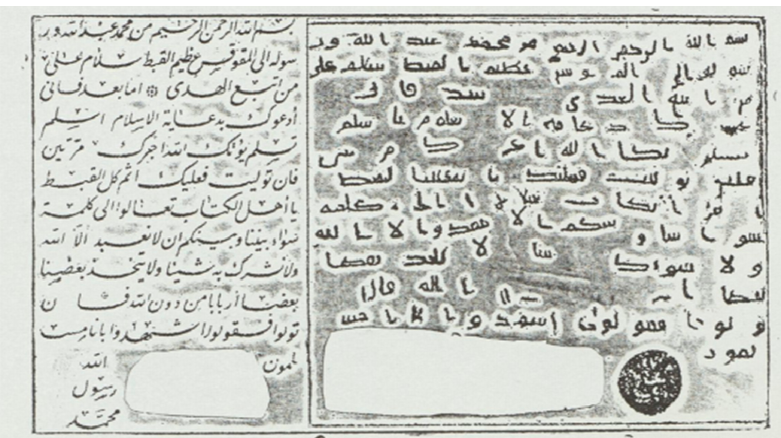
Figure 1. This is a scan of Prophet Mu ḥ ammad’s proposed covenant as sent to “al-Muqawqis”, the Christian sovereign of Egypt at the time, according to Islamic sources. The original covenant is displayed on the right. On the left, there is an appendage of what the text says, written in clearer handwriting.